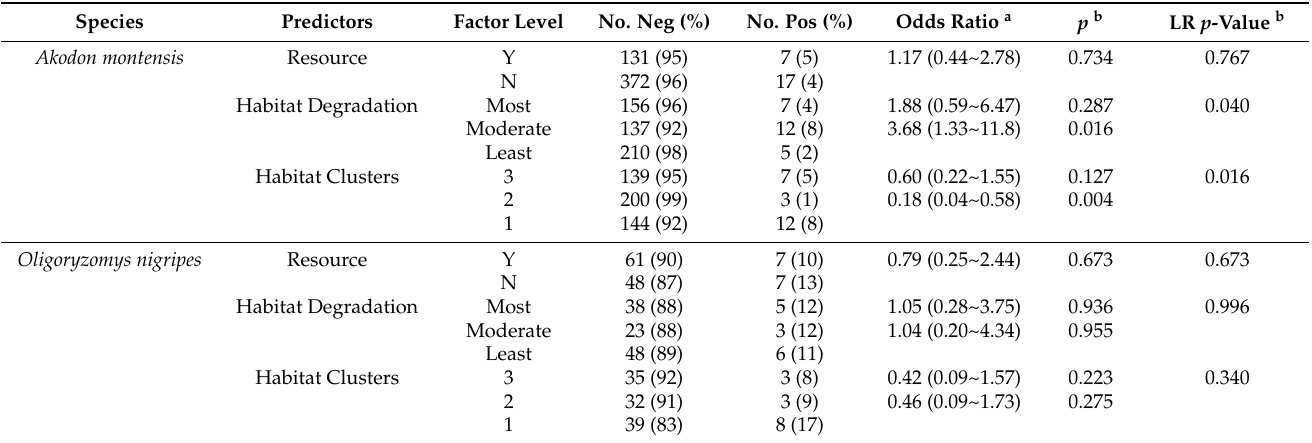
a Odds ratios for factor levels are in reference to the last level listed and include the parameter estimate followed by the 95% confidence interval in parentheses; b p -values test the statistical significance of the odds ratio and likelihood ratio (LR) test statistics,